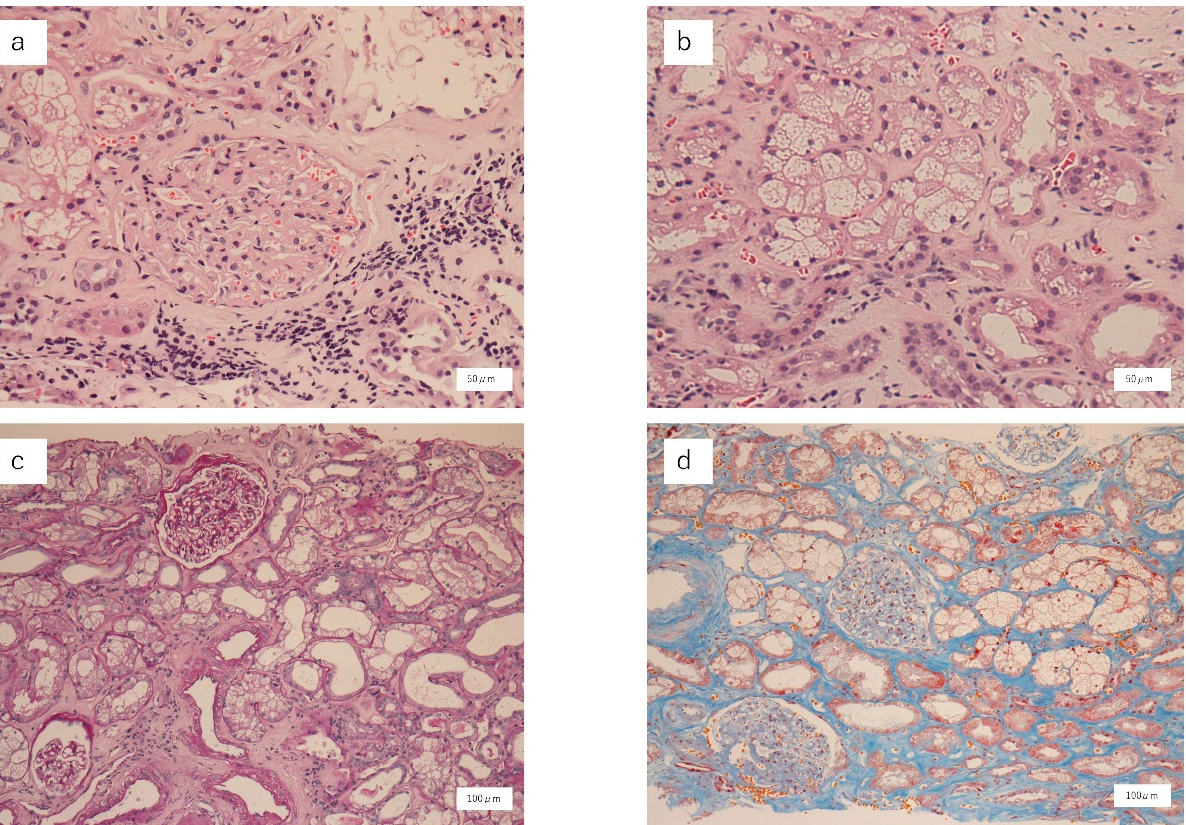
Figure 1. Renal biopsy findings. ( a , b ) Hematoxylin and eosin staining showing two glomeruli with global sclerosis. The other glomeruli are normal. The tubules are marked by vacuolar degeneration. ( c ) Periodic acid–Schiff staining showing mild lymphocyte infiltration in the interstitium and tubules. ( d ) Elastica–Masson staining showing unremarkable interstitial fibrosis in the interstitium and tubules.